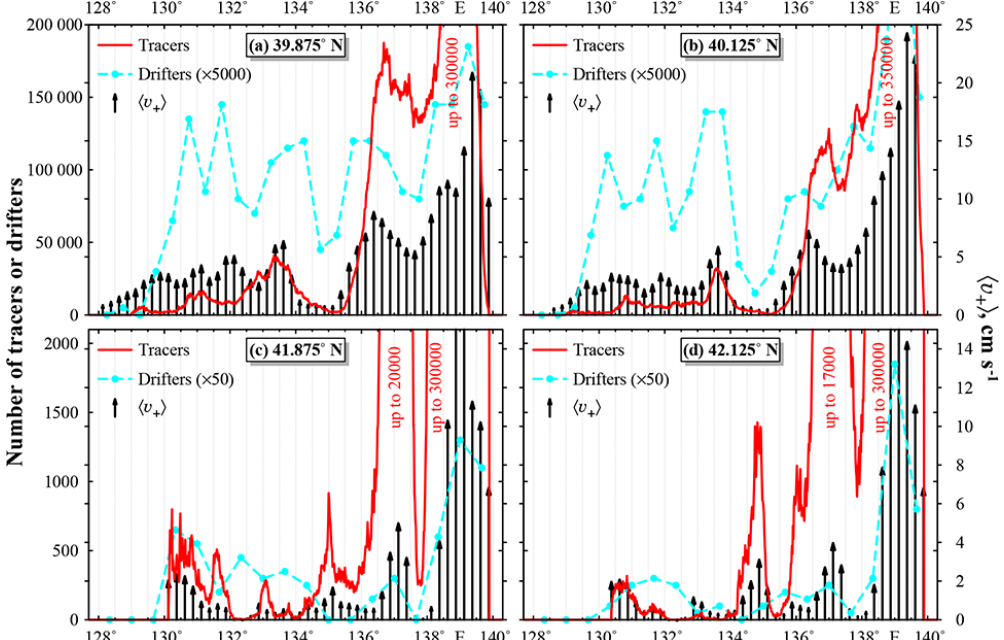
Figure 3. Meridional distributions of the number of tracers which crossed indicated zonal lines (solid curves), of the averaged northward component of the AVISO velocity in cms − 1 (arrows) and of the number of crossings of those zonal lines by available drifters (dashed curves). The period of observation is from 2 January 1993 to 15 June